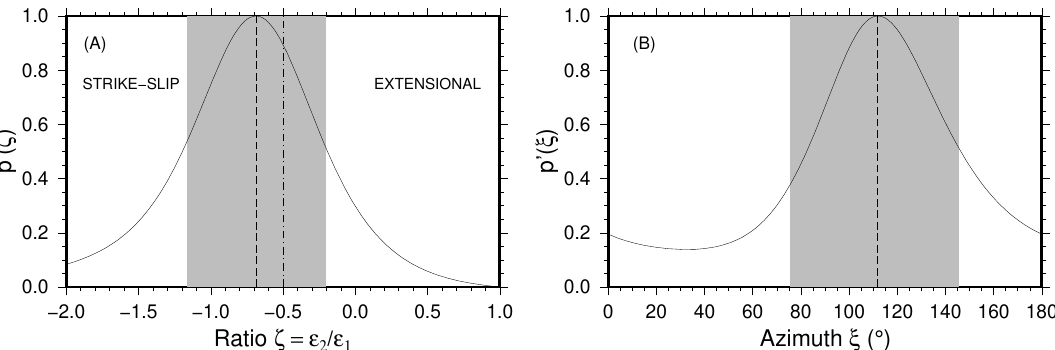
Figure 7. Marginal PDFs for ( A ) the ratio between horizontal principal strain rates, ζ = (cid:101) 2 / (cid:101) 1 , of extensional and strike-slip tectonic regimes and ( B ) the azimuth of maximum horizontal extension, ξ . The vertical dashed line indicates the maximum probability (set to 1) and the grey area denotes the 68 per cent confidence interval. The vertical dashed-dot line in panel A indicate the transition between strike-slip and extensional tectonic